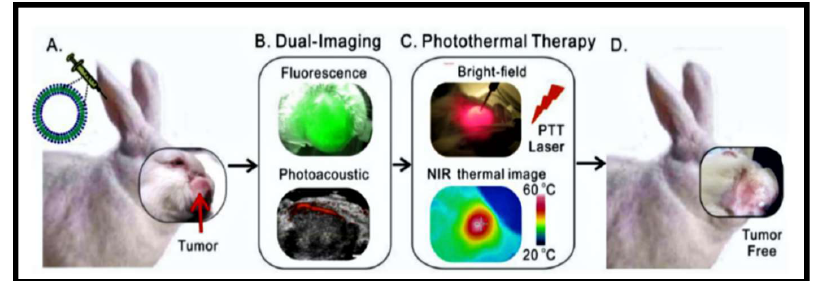
Figure 8. Dual functionality of porphyrins, ( A ) intravenous injection of the porphyrin, ( B ) dual (fluorescence and photoacoustic) imaging, ( C ) photothermal therapy application, and ( D ) post-treatment tumor free model